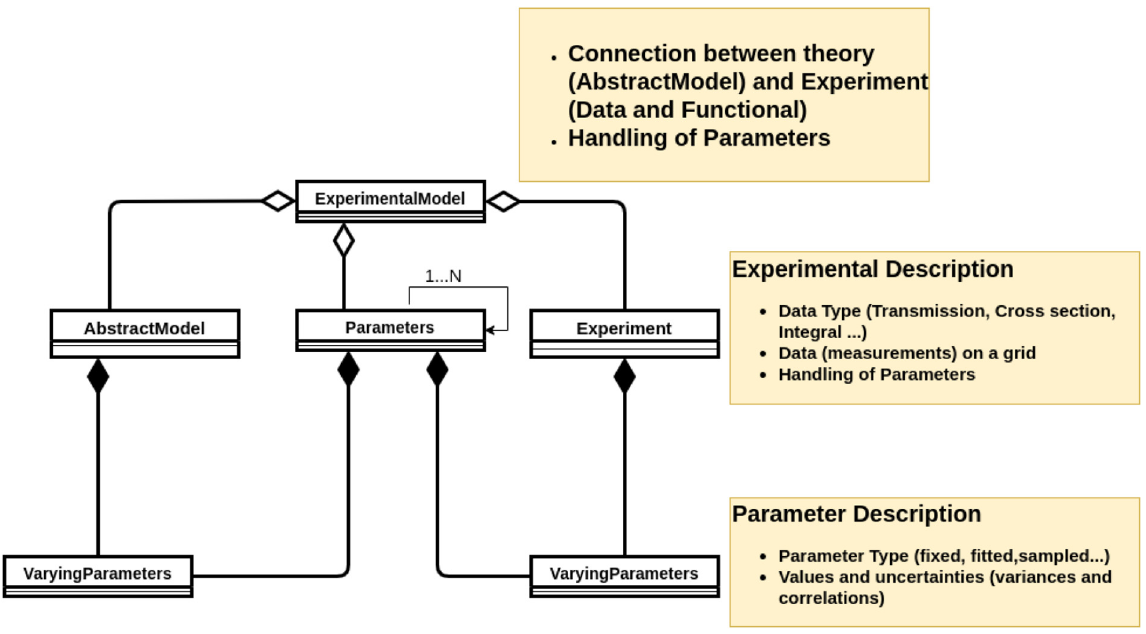
Fig. 2. Diagram description of CONRAD Experimentalmodel